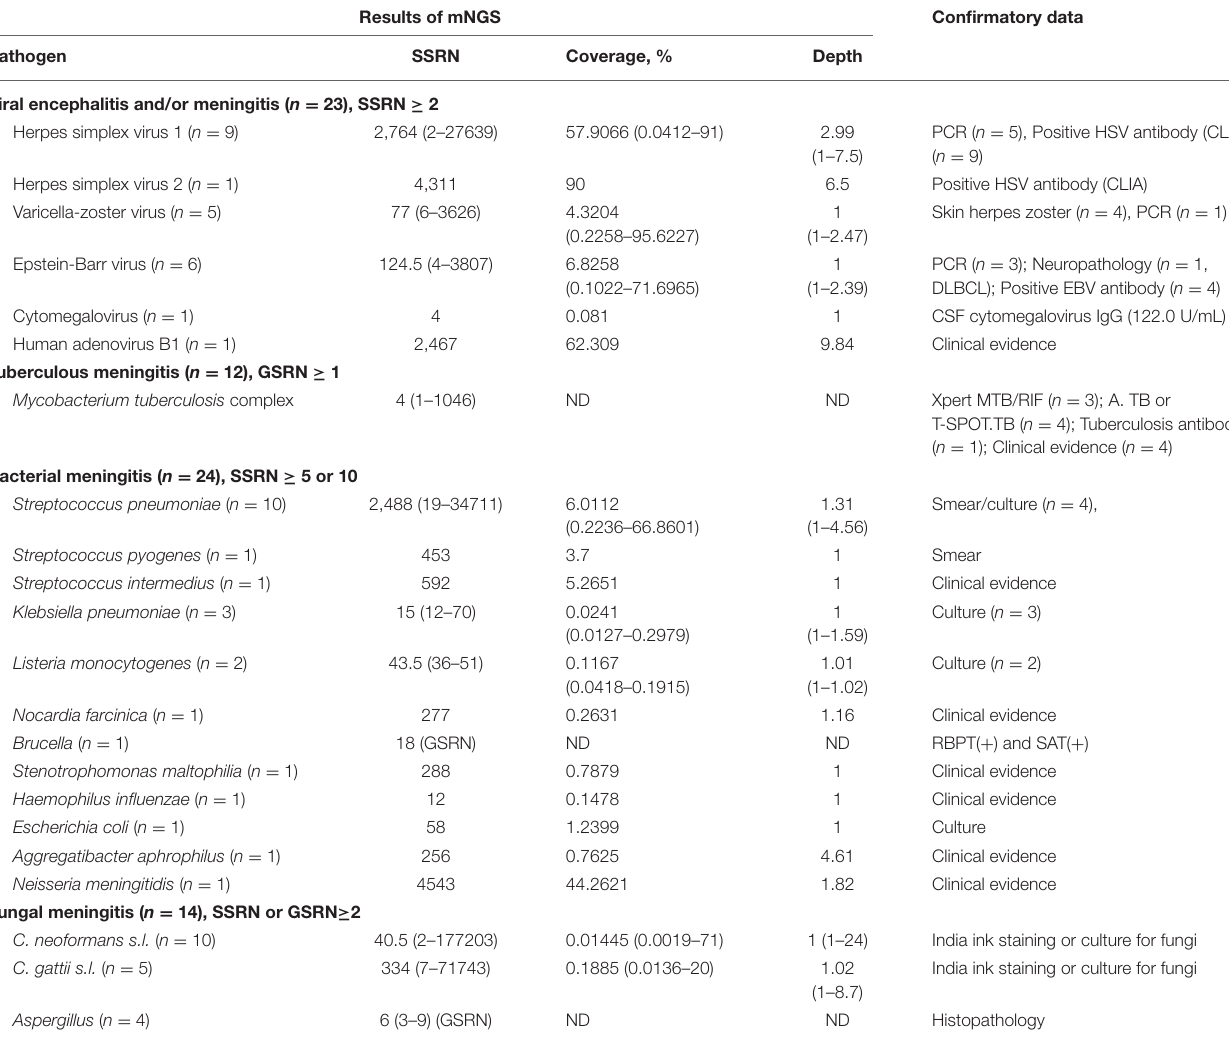
TABLE 3 | Positive mNGS results of the four types of CNS infection